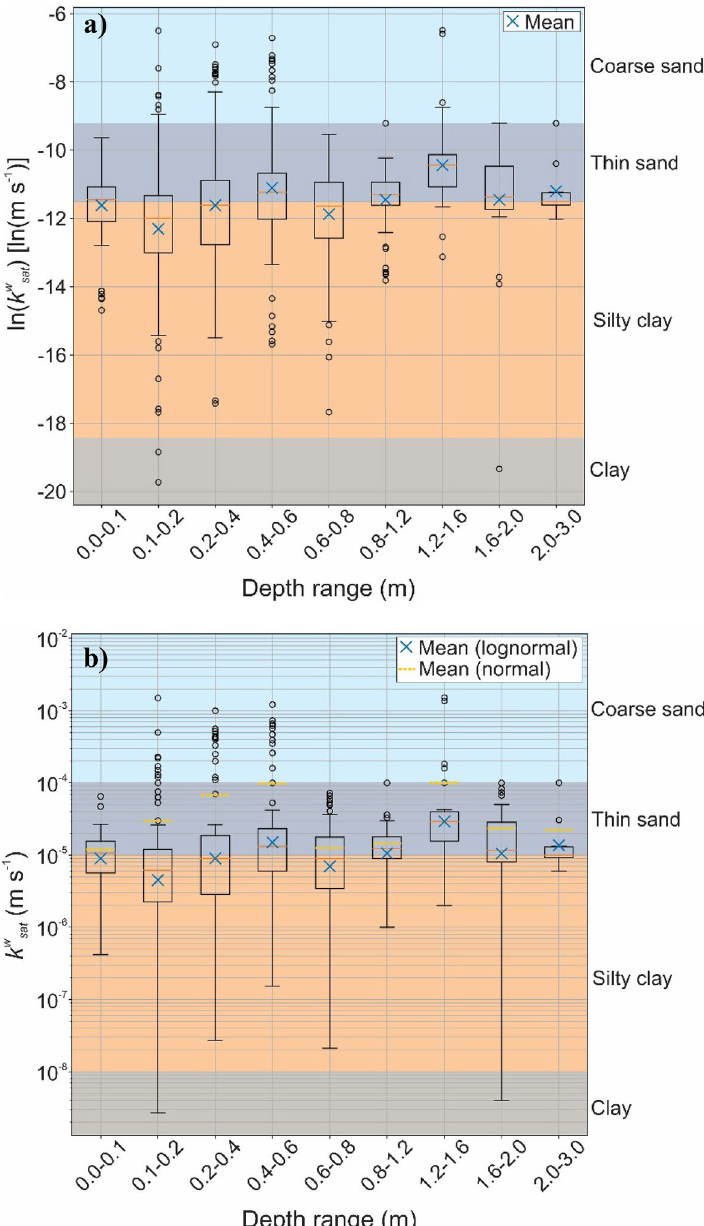
Figure 7. Distribution of the saturated hydraulic conductivity of lateritic soils by depth range, classified according to Table 2: ( a ) ln k sat ; ( b ) k sat